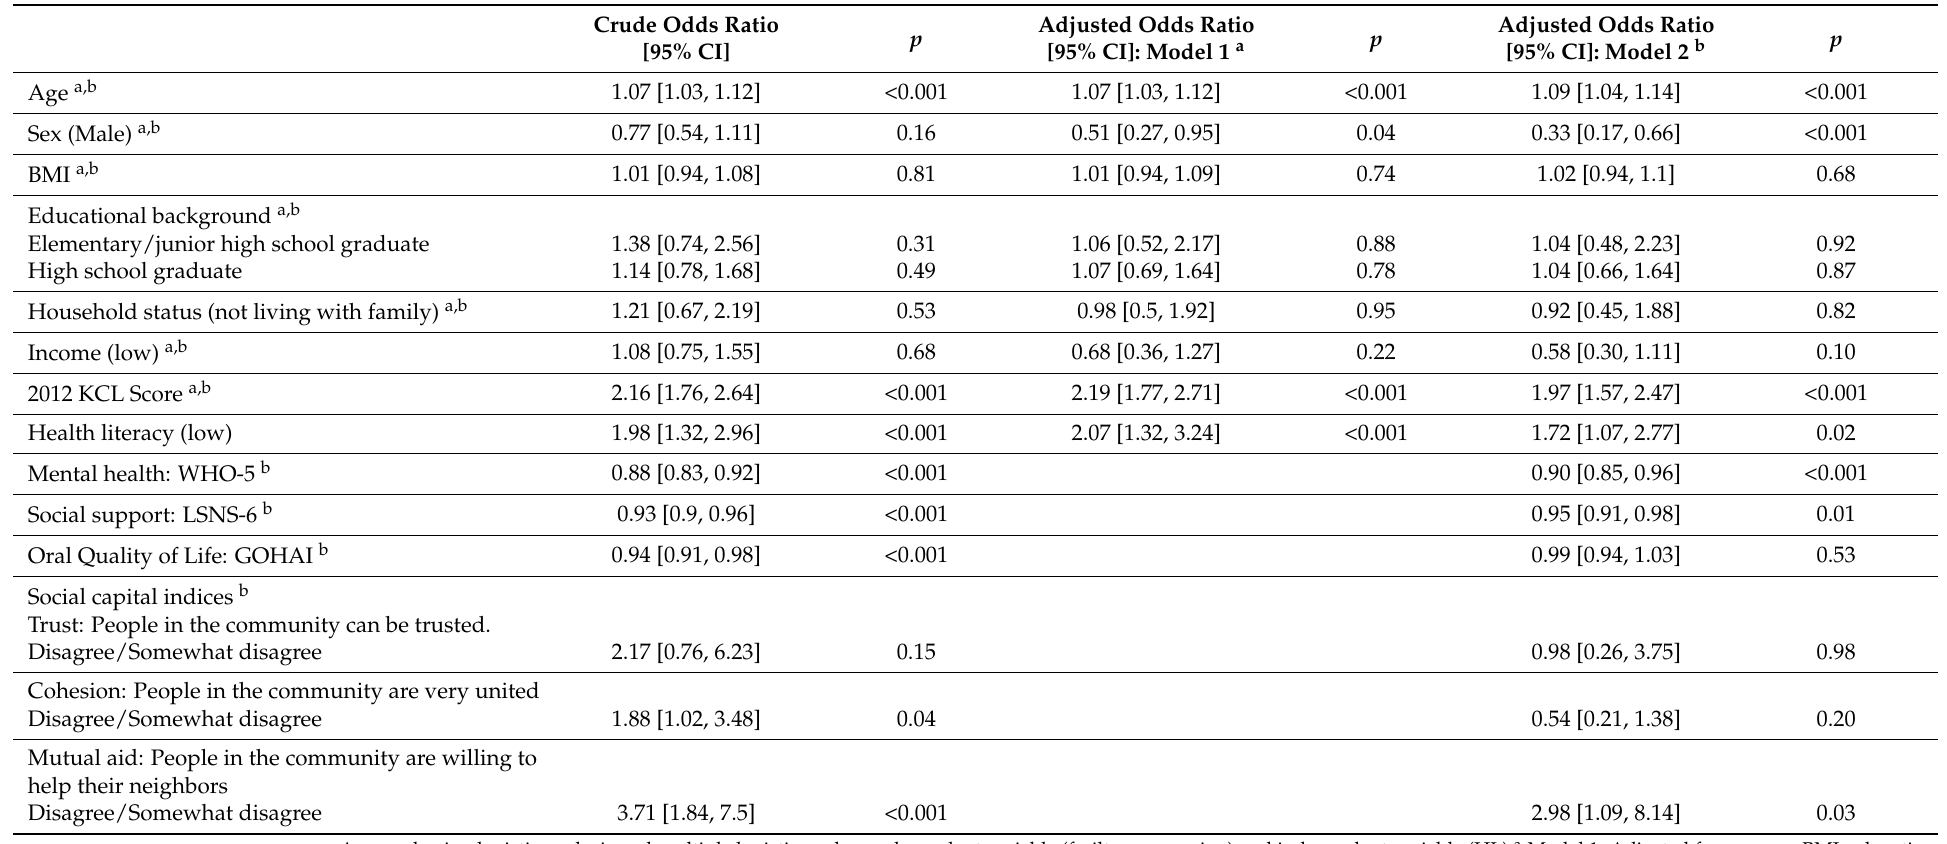
Table 3. Multivariate analysis of health literacy for frailty after 4